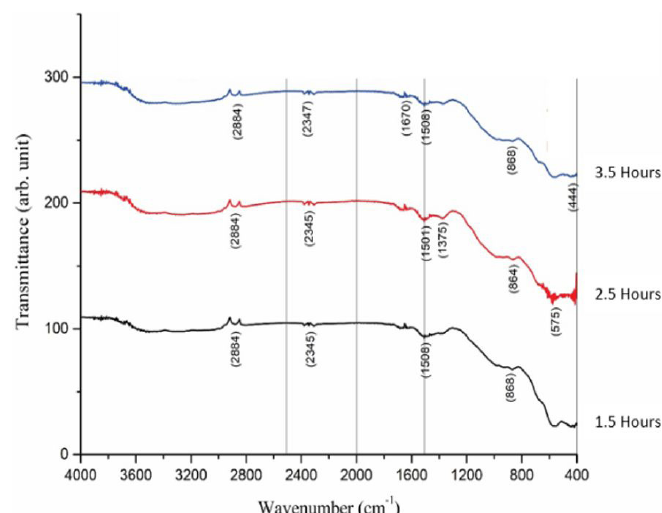
O functional-group identification of samples sintered for different Figure 3. ZnFe 2 4